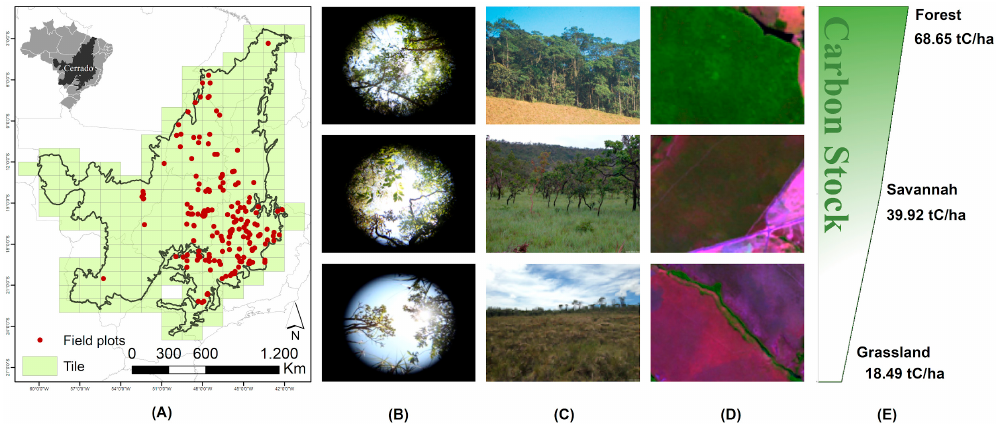
Figure 1. ( A ) Location of the Cerrado biome in Brazil and its subdivision into tiles of 1.5 degree by 1.0 degree, and field plots (in red), which were used to explore the spectral differences between vegetation types; ( B ) “fisheye” field photographs showing the canopy cover in a forest (top), savanna (middle), and grassland (bottom); ( C ) panoramic field photos of forest, savanna, and grassland; ( D ) R5G4B3 representative Landsat-8 color composites of forest, savanna, and grassland; and ( E ) average carbon stock estimates in each vegetation [29].